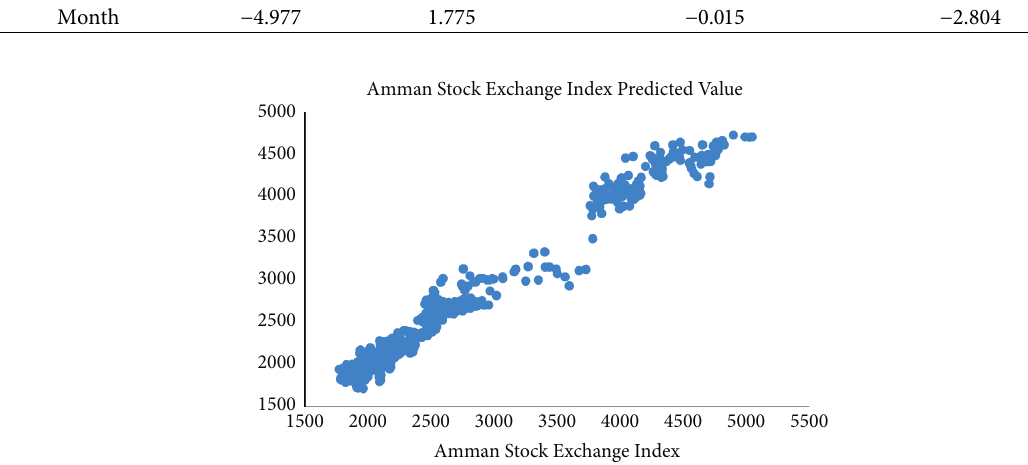
Figure 5: Relationship between predicted index and real